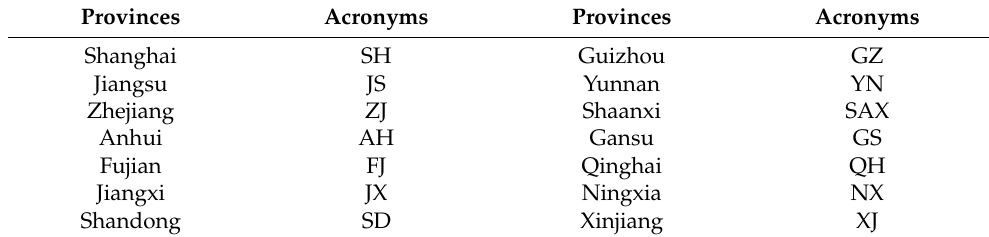
Figure 6. MSP map of ULGLE in 30 provinces in 2013.